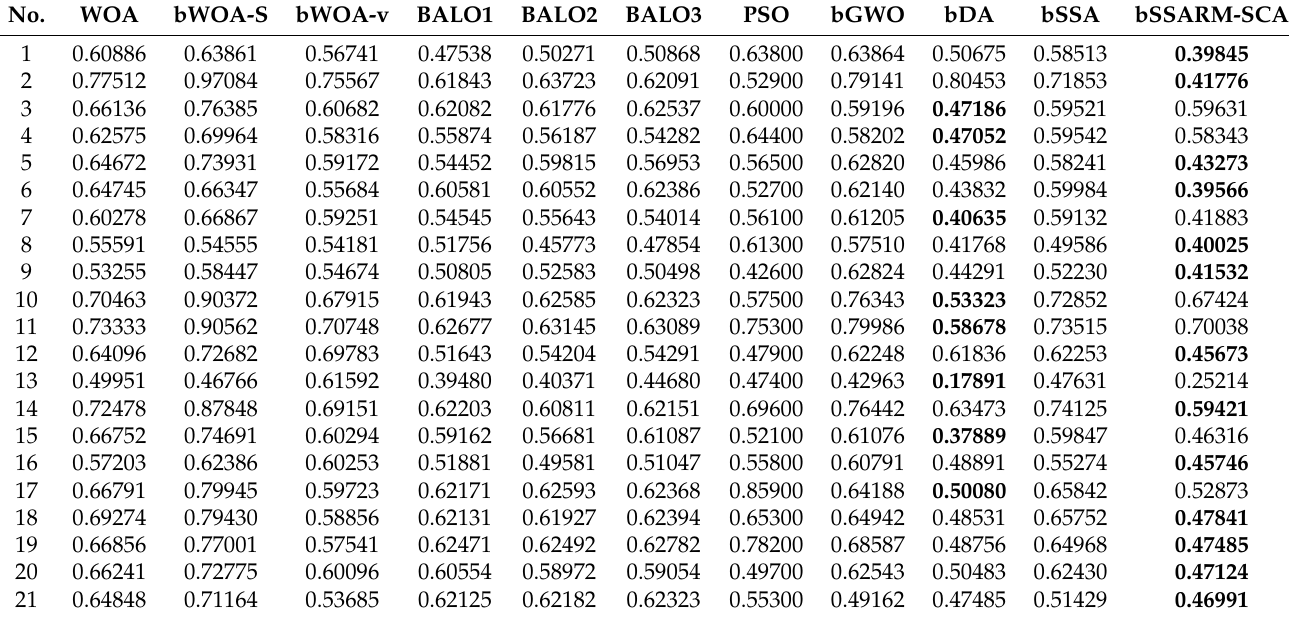
Table 16. Average selection size with various datasets for the compared algorithms with the three different initialization